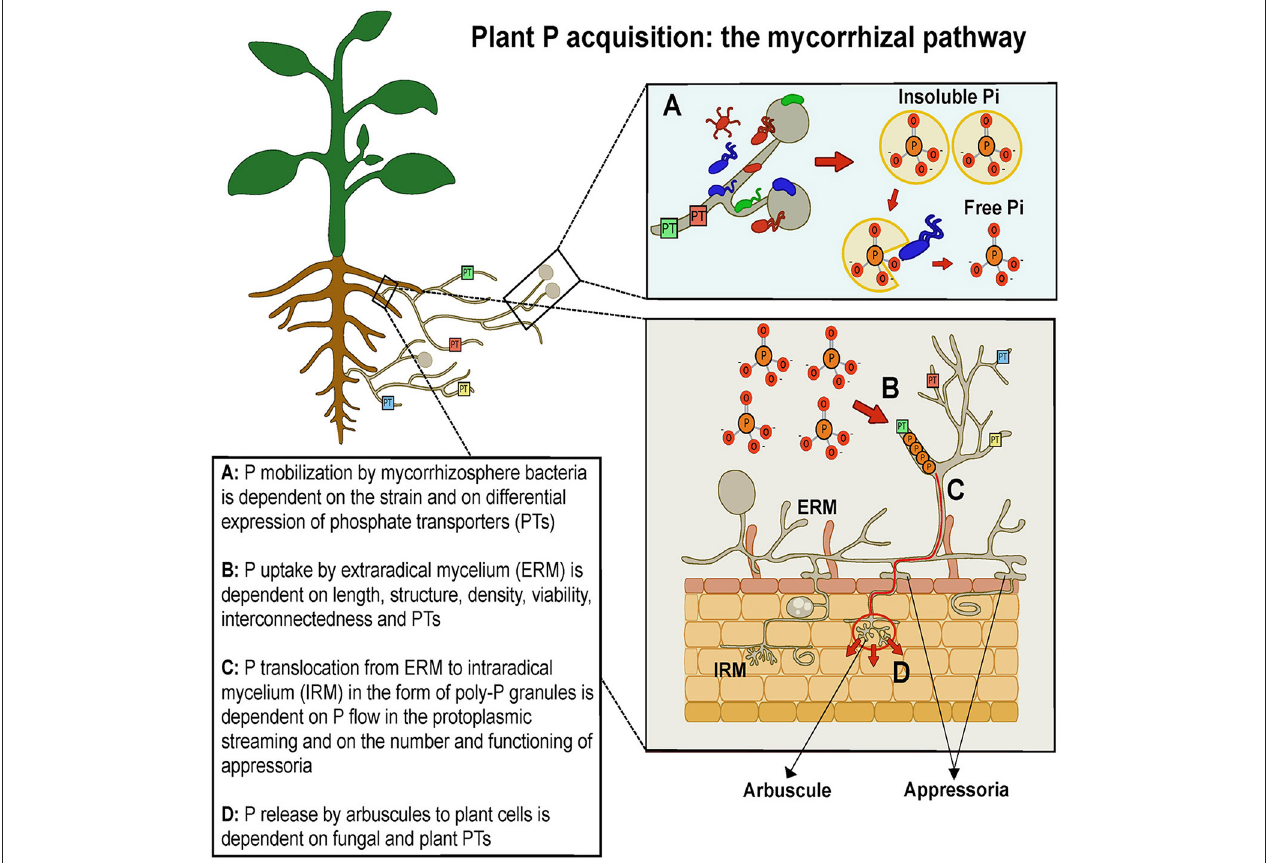
FIGURE 1 | Schematic drawing representing phosphate pathway from soil to plant via arbuscular mycorrhizal fungi and mycorrhizosphere